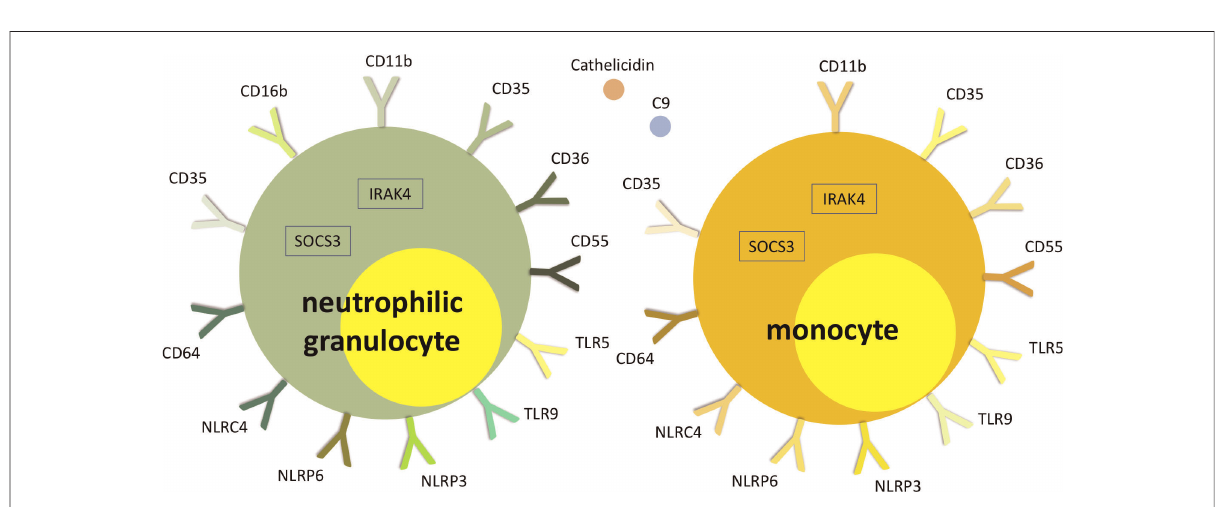
FIGURE 3 Visualization of signi fi cantly overexpressed genes related to neutrophilic granulocyte and monocyte surface proteins and transcription factors in patients with gangrenous appendicitis